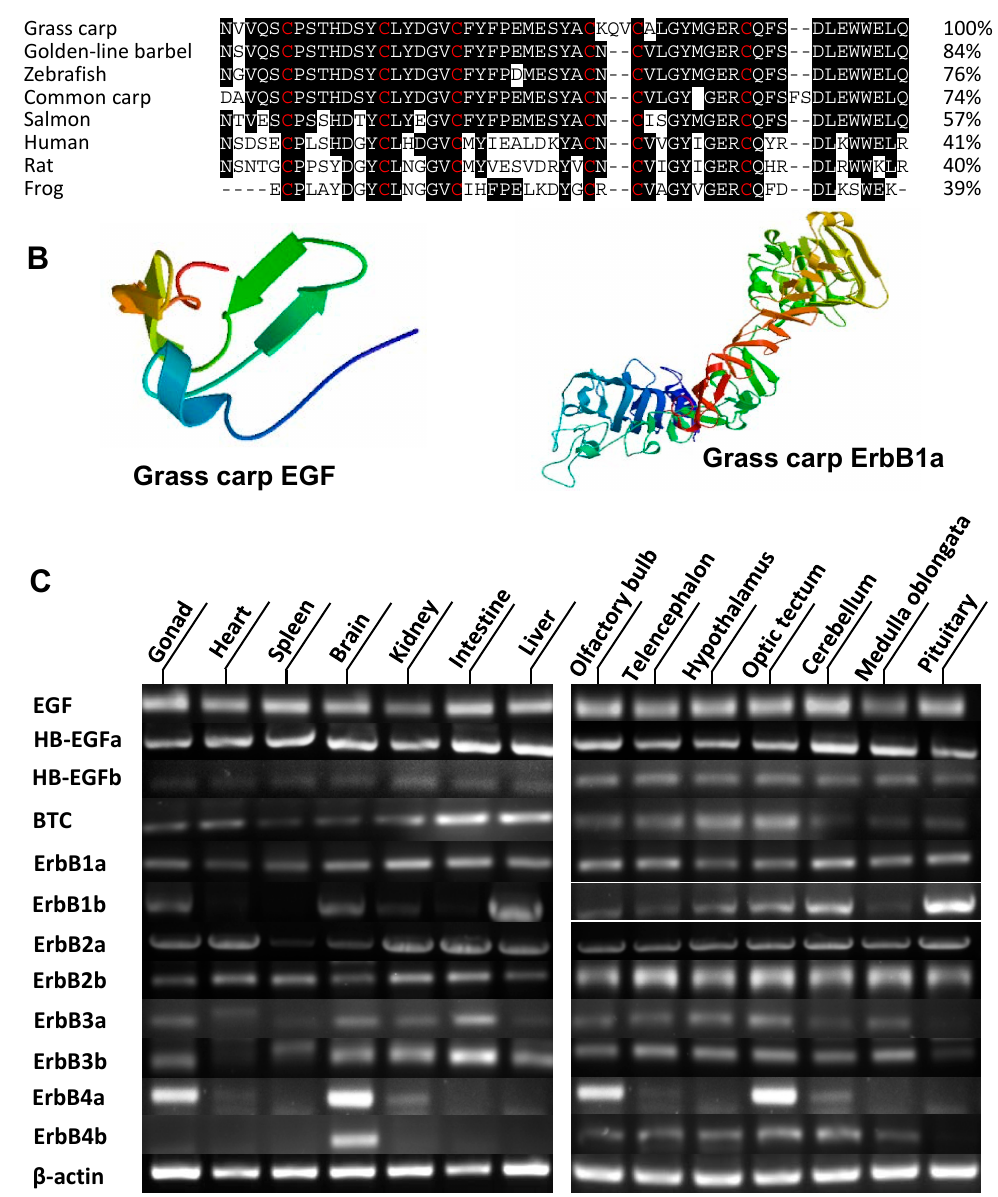
Figure 1. Sequence analysis and tissue distribution of grass carp epidermal growth factor ( EGF) and its receptors ErbBs. ( A ) Amino acid sequence alignment of grass carp EGF mature peptide with that of other vertebrates using the Clustal-W algorithm with Mac Vector program. The conserved amino acid residues in these sequences are shadowed in black. The disulfide bond across cysteine residues is indicated in red color. ( B ) The three-dimensional protein models of grass carp EGF and ErbB1a. ( C ) Transcript expression of EGF, heparin-binding EGF-like growth factor (HB-EGFs), betacellulin (BTC) and ErbBs in various brain regions of grass carp. Total RNA was isolated from various tissues and brain areas in grass carp and subjected to RT-PCR using primers specific for grass carp EGF, BTC, HB-EGFa, HB-EGFb, ErbB1a, ErbB1b, ErbB2a, ErbB2b, ErbB3a, ErbB3b, ErbB4a, and ErbB4b, respectively. Parallel RT-PCR for β -actin was also conducted to serve as the internal control.